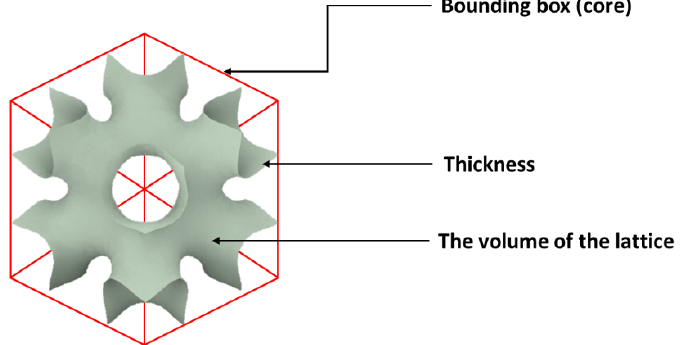
Figure 3. Schematic of the bounding box and lattice volume of an SPS.